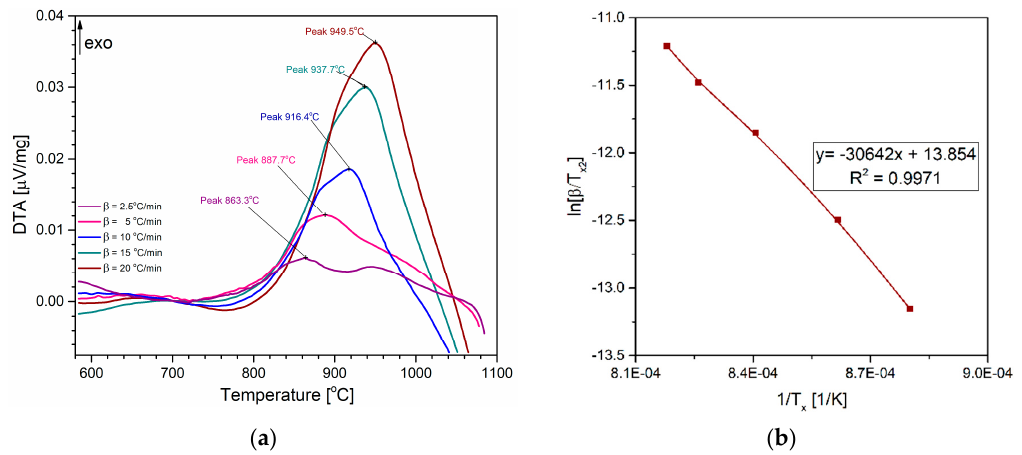
Figure 8. DTA crystallization curves ( a ) (heating rate: 2.5, 5, 10, 15 with steps of 20 °C/min) and the interpretation of kinetic evaluation with the Kissinger equation ( b ) of pure GeO 2 glass.